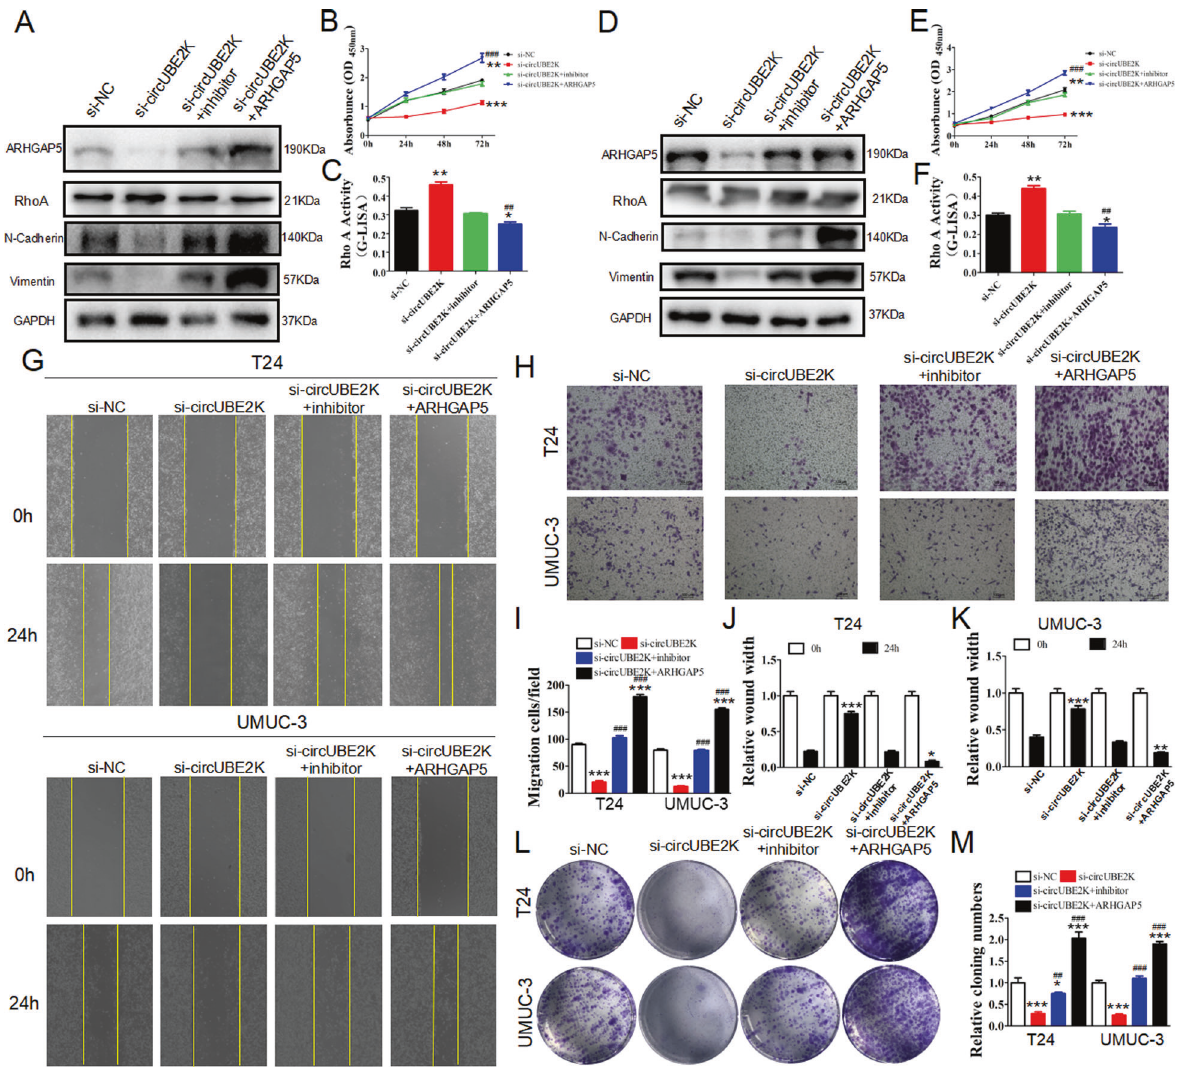
Fig. 5 Downregulation miR-516b-5p or ARHGAP5 overexpression restored the proliferation and invasion ability of BC cells after circUBE2K was silenced. T24 and UM-UC-3 cells were transfected with scramble siRNA (si-NC), circUBE2K knockdown siRNA (si-circUBE2K), circUBE2K siRNA together with miRNA inhibitor (si-circUBE2K + inhibitor), circUBE2K siRNA together with ARHGAP5 overexpression vector (si- circUBE2K + ARHGAP5). A , D Cells were then subjected to western blot analysis anti-ARHGAP5, anti-N-Cadherin, anti-Vimentin and anti-GAPDH. B , E CCK-8 assays of transfected T24 and UM-UC-3 cells at 0 h, 24 h, 48 h, and 72 h after transfection were performed ( *** P < 0.001, ** P < 0.01 versus si-NC, ### P < 0.001 versus si-circUBE2K). C , F RhoA G-LISA activation assays were used to evaluate RhoA activity in transfected T24 and UM-UC-3( ** P < 0.01, * P < 0.05 versus si-NC, ## P < 0.01 versus si-circUBE2K). G , J , K Wound healing assays at 0 h and 24 h were done to assess cell migration ability (Upper panel: T24-si-NC, T24-si-circUBE2K, T24-si-circUBE2K + inhibitor, T24-si-circUBE2K + ARHGAP5; Lower